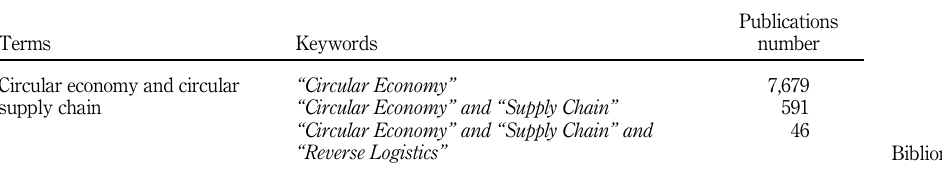
Table 2. Bibliometric